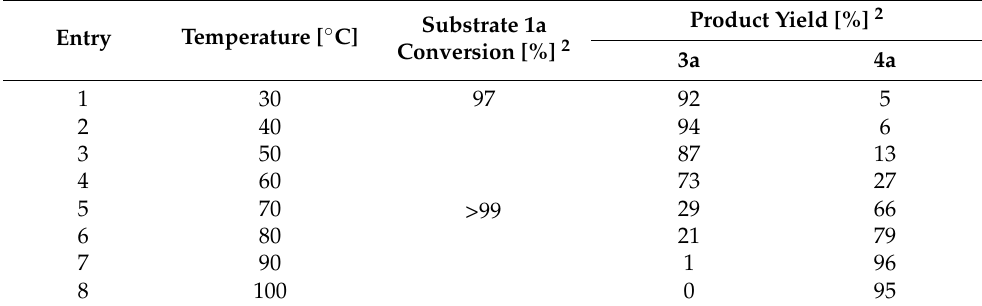
The analysis of data from Table 2 concludes that the best medium for the studied transformation is triethyl orthoacetate 2a when used in large excess with respect to sub- strate (over 5 equiv.). After selection of the best solvent for reaction, we studied the impact of temperature on the esterification (Table 3). Reactions of butylphosphonic acid 1a with orthoacetate 2a were performed at temperatures varying from 30 ◦ C to 100 ◦ C. The increase in the reaction temperature from 30 to 40 ◦ C resulted in a higher conversion of the substrate (over 99%) and slightly influenced the yield of the product (Table 3, entries 1 and 2). At ele- vated temperatures, the conversion of the substrate became quantitative (Table 3, entries 2–8) and the selectivity towards diester increased gradually. The amount of monoester 3a in the reaction mixture dropped to 1% at 90 ◦ C (Table 3, entry 7). At 100 ◦ C, partial decomposition of the product was observed (Table 3, entry 8). Table 3. Temperature influence on the selectivity of esterification of butylphosphonic acid ( 1a ) with triethyl orthoacetate ( 2a ); 1 Section